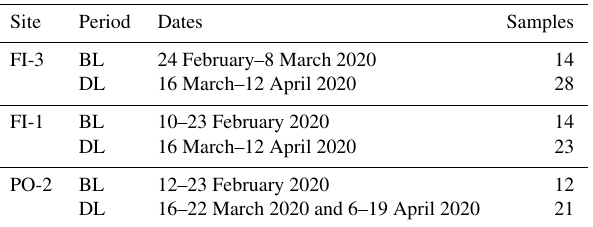
Table 2. Sampling periods of the subset samples used for PM 10 chemical